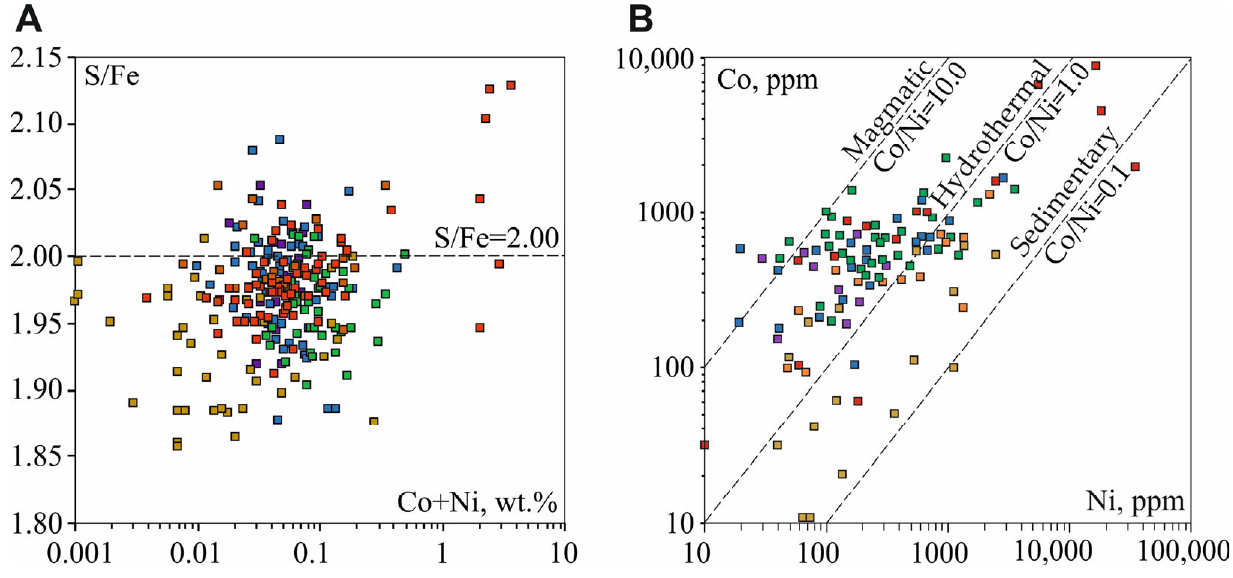
Figure 20. Distribution of the total impurity Co+Ni in Py3 relative to the indicator S/Fe ( A ) of the studied OGDs, central YKMB. ( B ) Diagram of concentration ratios Ni and Co in Py3 of the studied deposits. The demarcated fields are after [115]. See symbols in Figure 16.